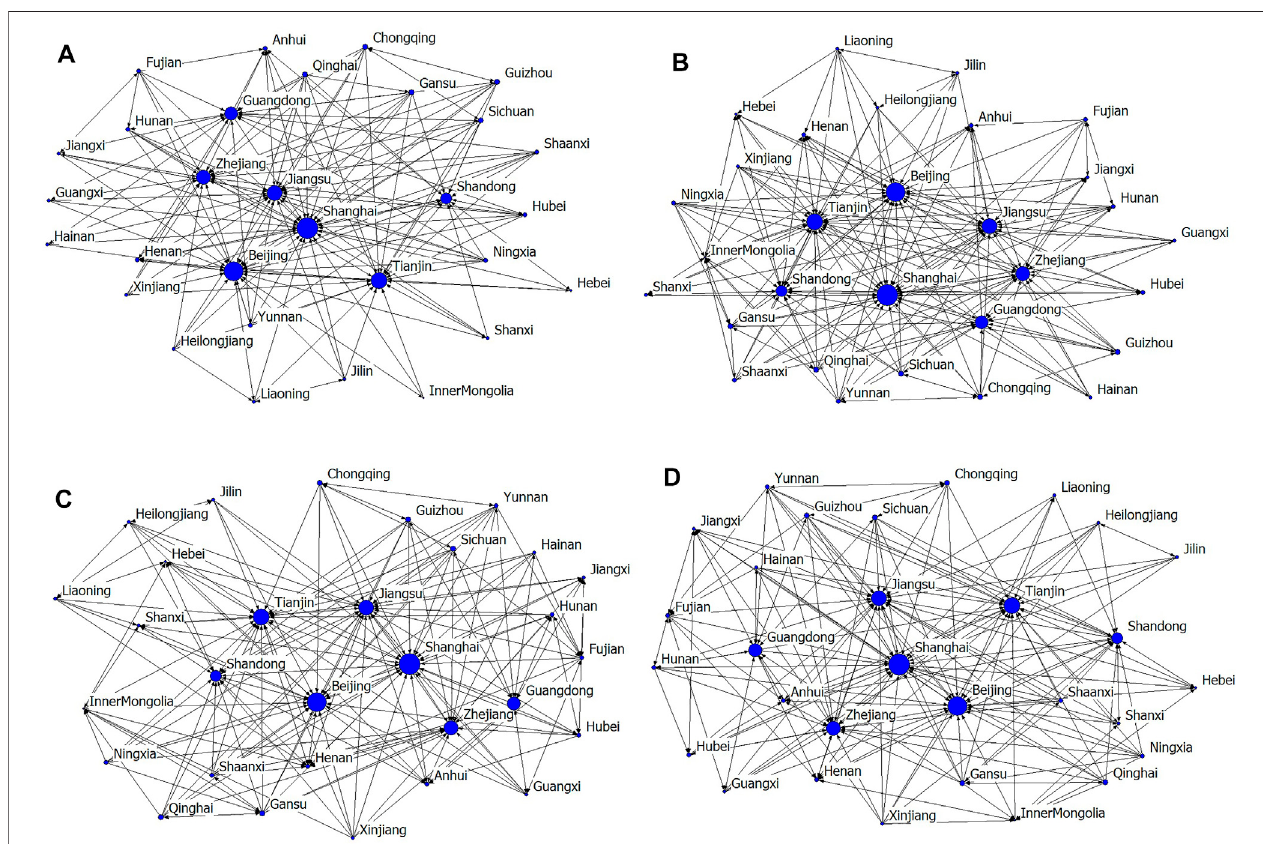
FIGURE2| SpatialnetworkdiagramoftheinformationentropyofthecarbonemissionstructureinChinaformainyearsfrom2005to2020. (A) 2005, (B) 2010, (C) 2015, and (D)